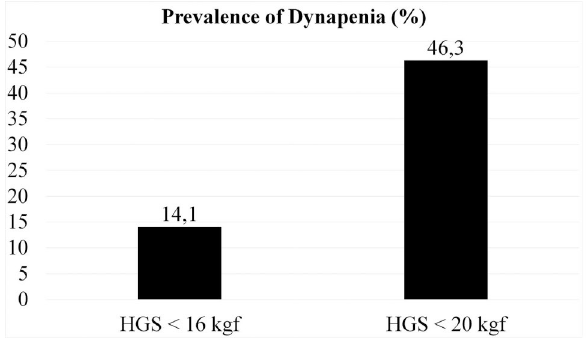
Figure 3 - Prevalences of dynapenia were identified by different cutoff points in older women. Jequié-BA, Brazil,